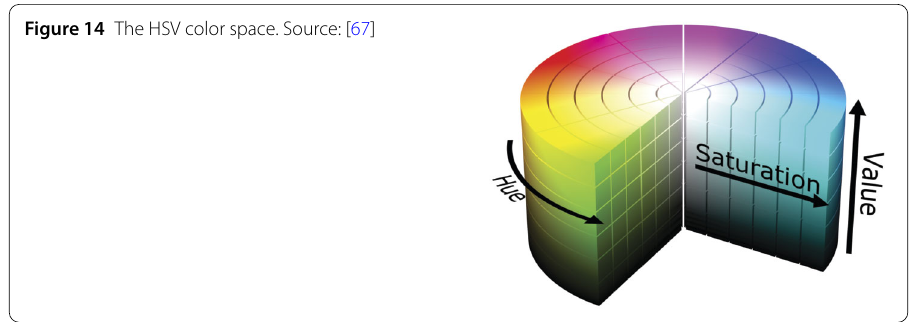
Figure 14 The HSV color space. Source: